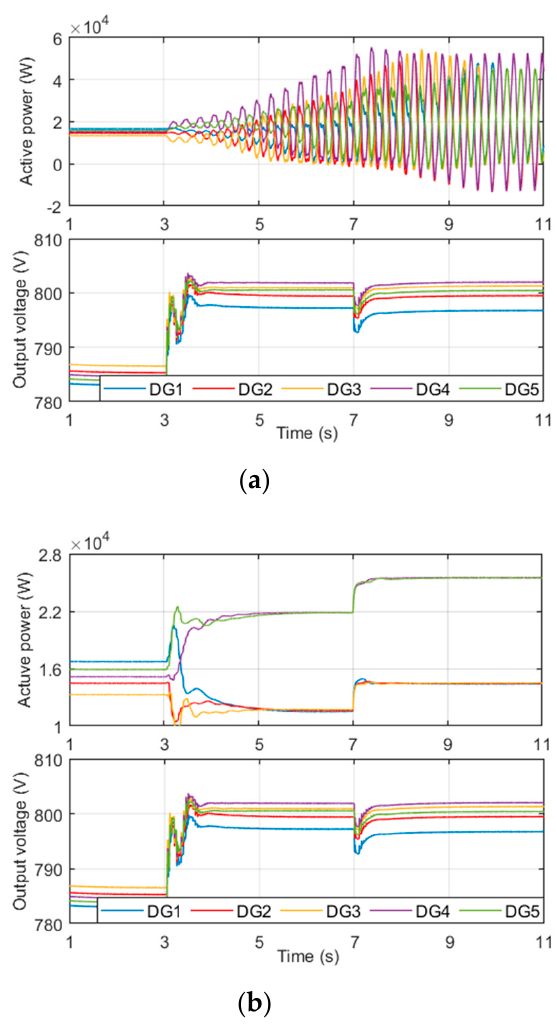
Figure 7. Simulation results of active powers and output voltages with sampling interval as 0.05 s using different algorithms. ( a ) Consensus algorithm. ( b ) Fast convergence algorithm.